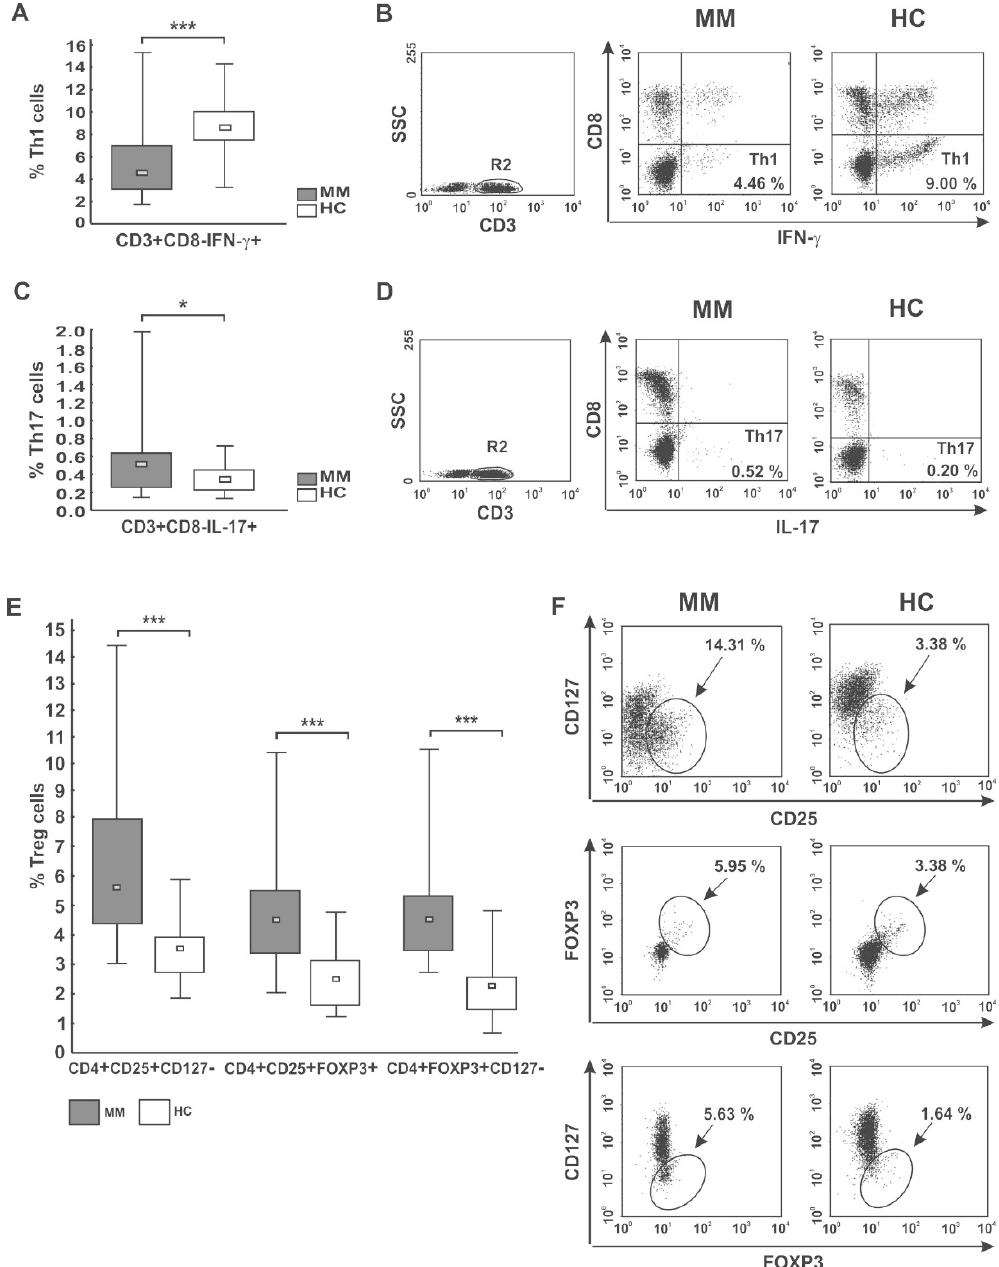
Figure 2. CD4 T cell capacity for cytokine secretion (IFN- γ , IL-17) and peripheral distribution of Treg cells. ( A , B ) IFN- γ - (Th1) and ( C , D ) IL-17-secreting cells (Th17) were phenotyped by flow cytometry as CD3 + CD8 − IFN- γ + and CD3 + CD8 − IL-17 + cells, respectively. ( E , F ) Treg cells were identified as the following subsets: CD4 + CD25 + CD127 − , CD4 + CD25 + FOXP3 + , and CD4 + FOXP3 + CD127 − cells. Boxes and whiskers 25th–75th interquartile range and minimum-maximum, respectively; the median is the central square in each box. *** represents p < 0.001 and * represents p < 0.05. Numbers on dot plots represent the percentage of Th1, Th17, and Treg cells within PBMCs in MM patients and healthy subjects (HC). Significant decreases in PB Th1 and increases in both Th17 and Treg cells among patients were found in all analyses using the Mann-Whitney U-test.